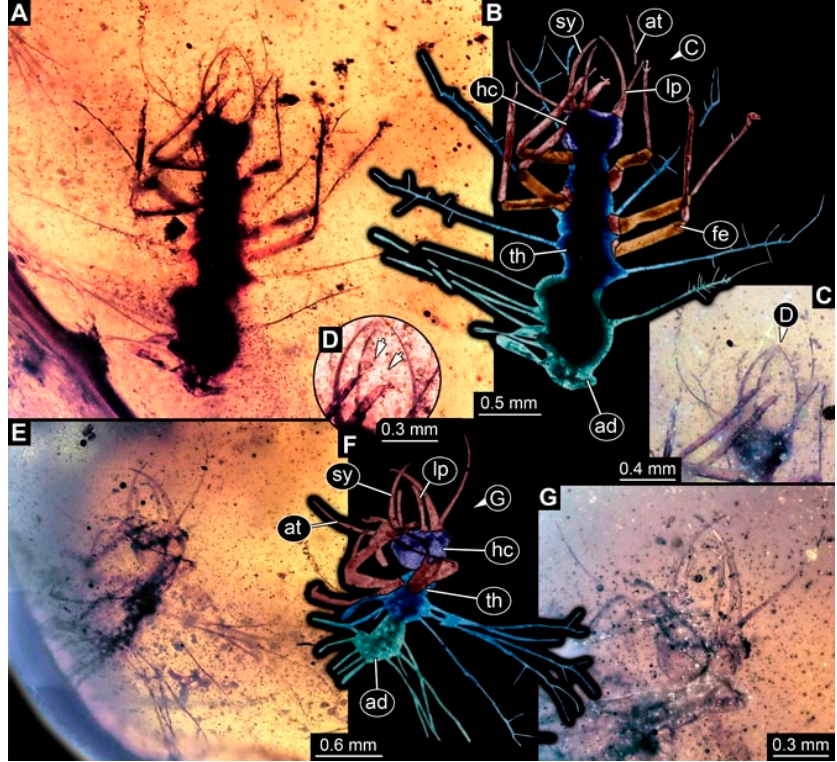
Figure 38. Two specimens in Myanmar amber. ( A – D ) Specimen 4865 (PED 1229a). ( A ) Ventral view. ( B ) Ventral view, colour-marked. ( C ) Close-up of head capsule in ventral view. ( D ) Close-up of trunk appendages with empodia (arrows). ( E – G ) Specimen 4866 (PED 1229b). ( E ) Ventral view. ( F ) Ventral view, colour-marked. ( G ) Close-up of head capsule in ventral view. Abbreviations: ad = abdomen; at = antenna; fe = femur; hc = head capsule; lp = labial palp; sy = stylet; th = thorax. (48) Specimen 4867 (PED 1258a) is preserved in Myanmar amber. It is accessible in a dorsal (Figure 39A,B) and ventral view (Figure 39C). A prominent camouflaging cloak is present. The antenna bears a prominent seta distally. Each tarsus of the trunk appendages carries a trumpet-shaped empodium (Figure 39D). Prominent protrusions on the back are apparent. The overall length of the larva is 1.78 mm. (49) Specimen 4868 (PED 1258b) is preserved in Myanmar amber, in the same amber piece as PED 1258a. It is accessible in a dorsal (Figure 39G) and ventral view (Figure 39E,F). A prominent camouflaging cloak is present, but more towards the posterior (Figure 39G,H). The antenna bears a prominent seta distally. Each tarsus of the trunk appendages carries a trumpet-shaped empodium (Figure 39I). Prominent protrusions on the back are apparent. The overall length of the larva is 1.94 mm.